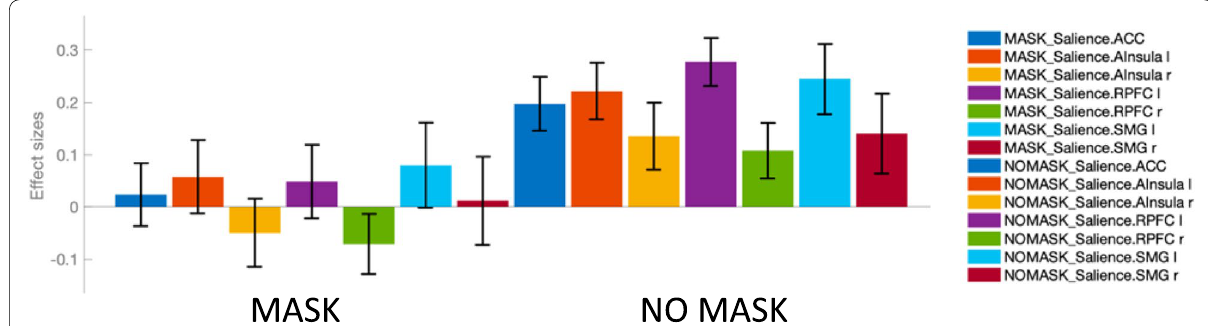
Fig. 2 Detailed analysis of the significant cluster identified of the seed‑to‑voxel analysis using the salience network (SN) as seed region (see Fig. 1). The functional connectivity between the SN and this cluster was significantly lower ( F ([7 16]) 8.60; p ‑false discovery rate < 0.001) for MASK versus NOMASK conditions. Of note, this effect was present for all seven subregions of the